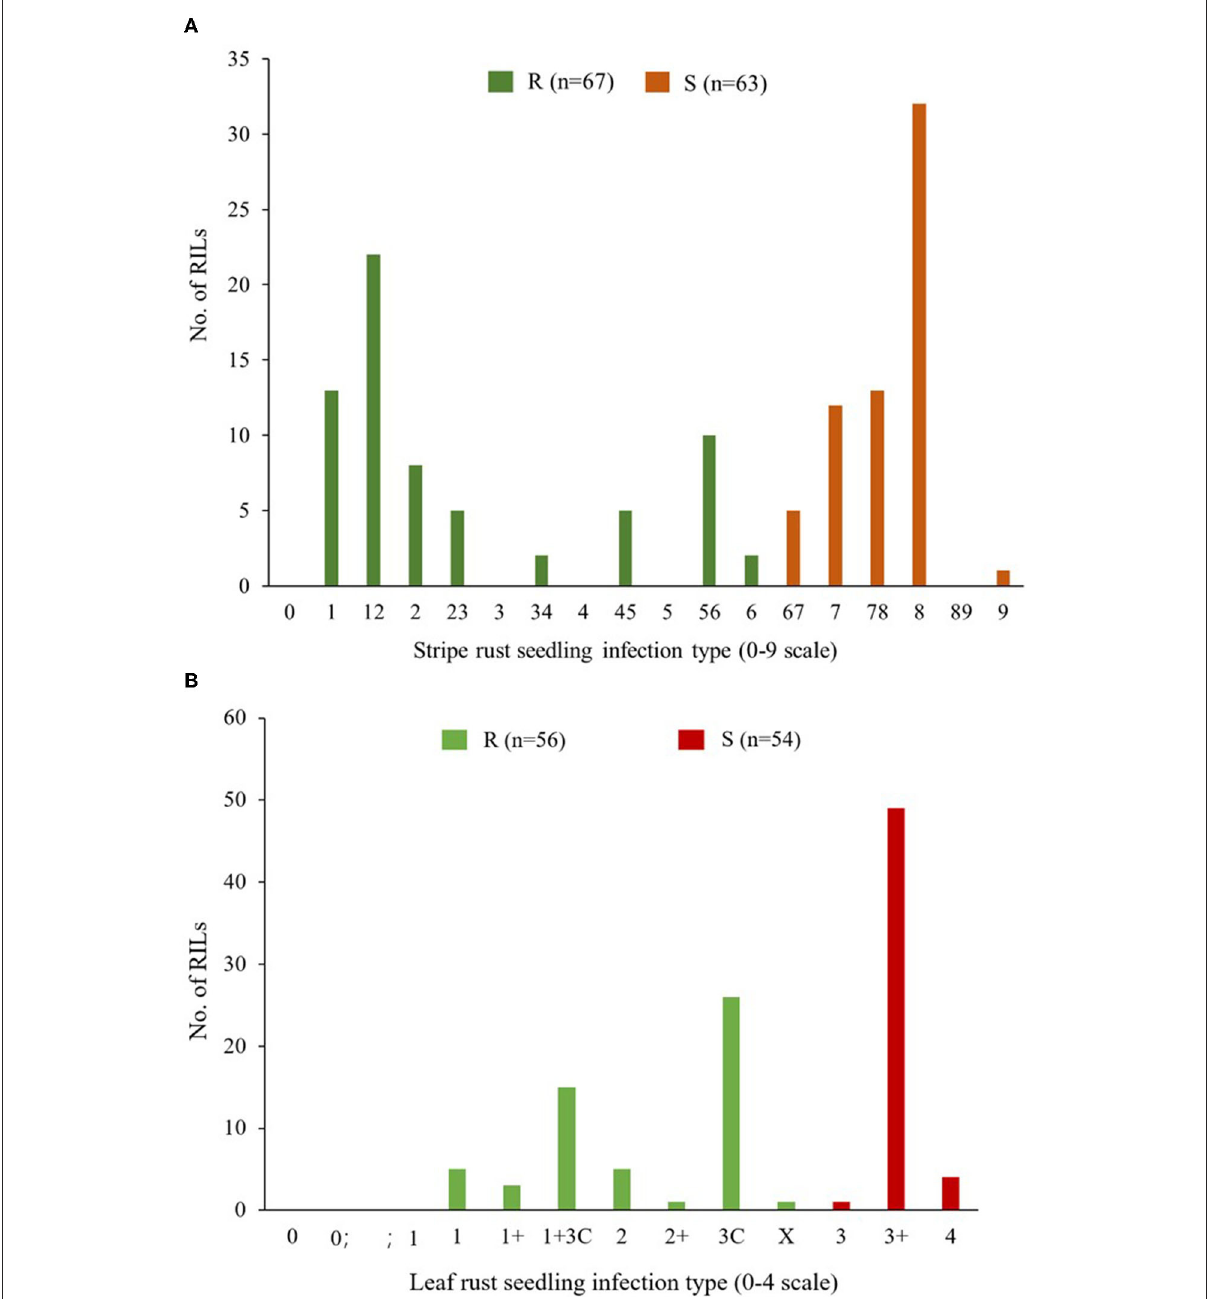
FIGURE1 Frequency distributions of the Apav#1 × Mucuy recombinant inbred lines (RILs) for stripe rust (YR) responses (A) and leaf rust (LR) responses (B) grouped as resistant (R) and susceptible (S) at the seedling stage. For stripe rust, IF ≤ 6 is in the R group, while the rest lines with IF ≥ 67 are in the S group. For leaf rust, IF ≤ X is the R group and IF ≥ 3 is the S group.